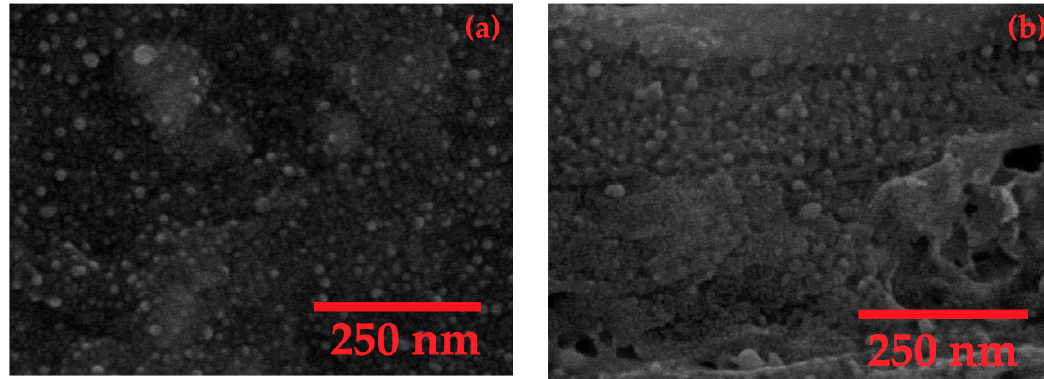
Figure 5. Scanning electron microscope (SEM) images of the synthesized AgNPs / GO nanocomposite ( a ) before and ( b ) after 30 cycles of CV measurement with Na + .